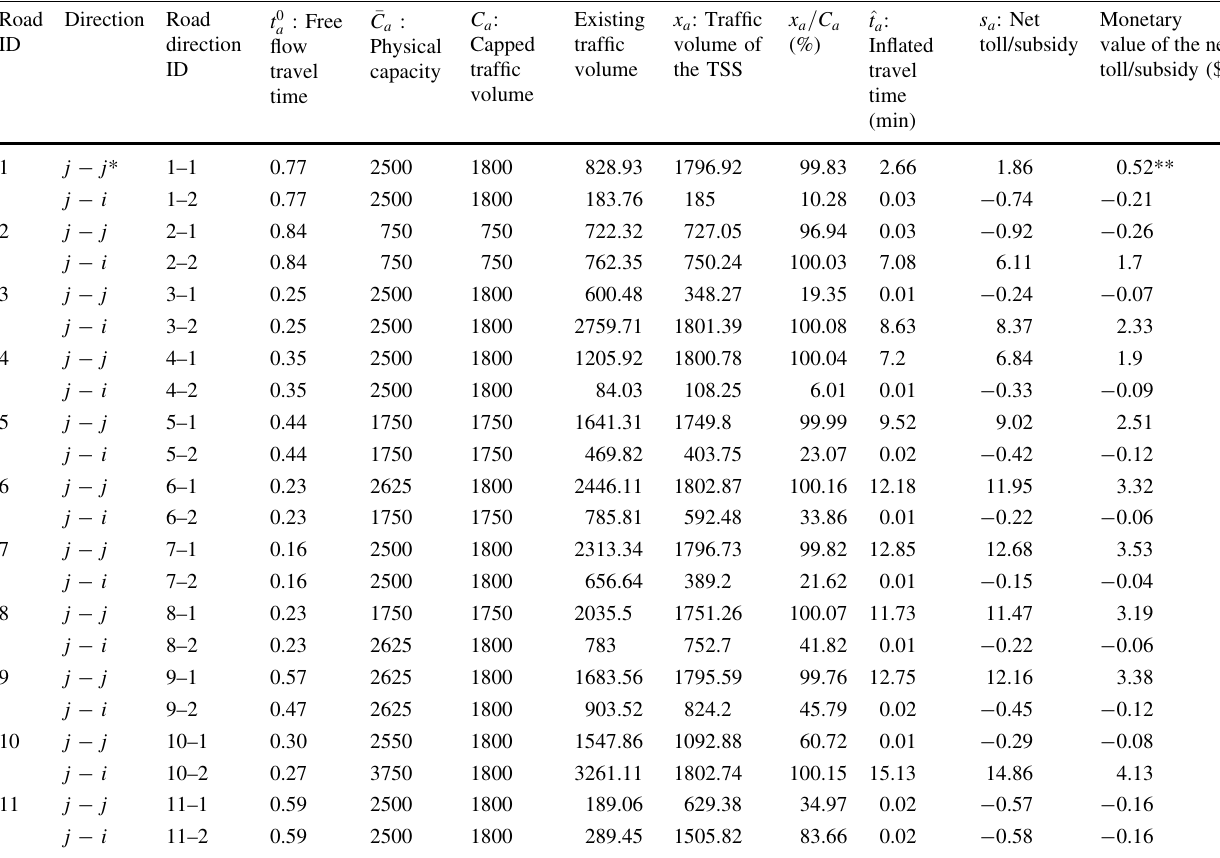
Table 2 Winnipeg case study, input and output values Road Direction Road